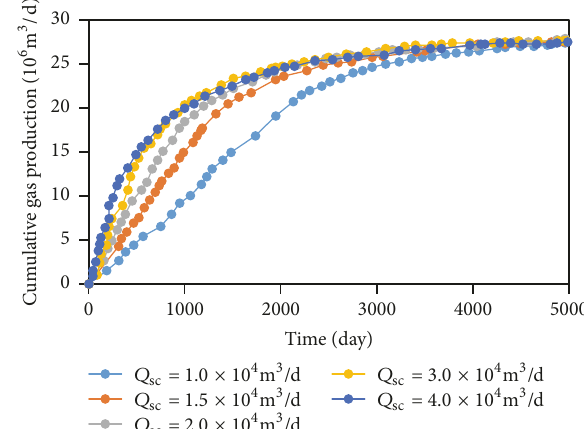
Figure 22: Gas rate under different initial gas rates.